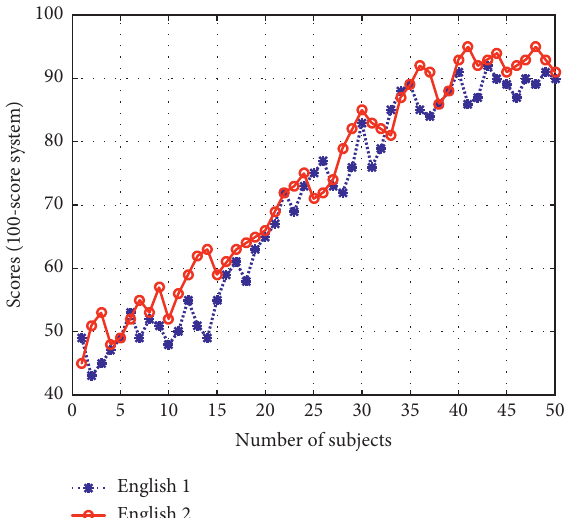
Figure 7: Comparison of English class before and after the linear mixed model proofreading.